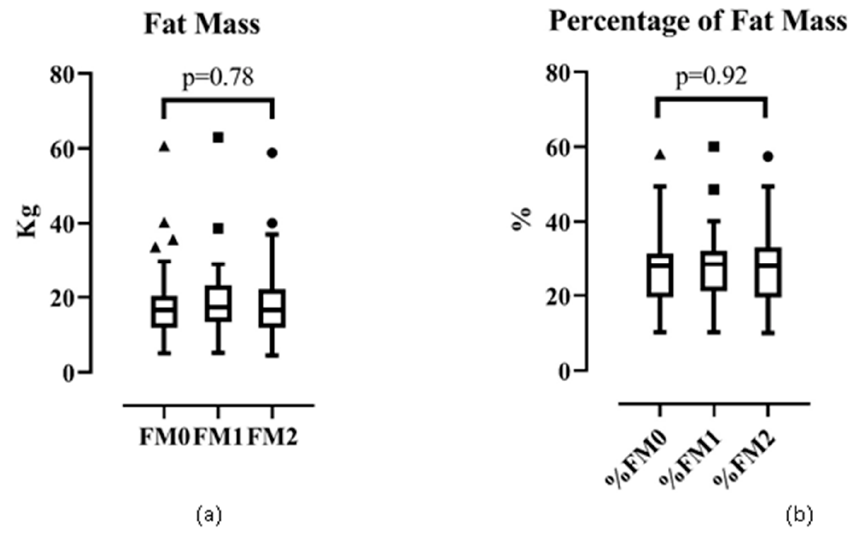
Figure 2. Trend of ( a ) fat mass and ( b ) percentage of fat mass.